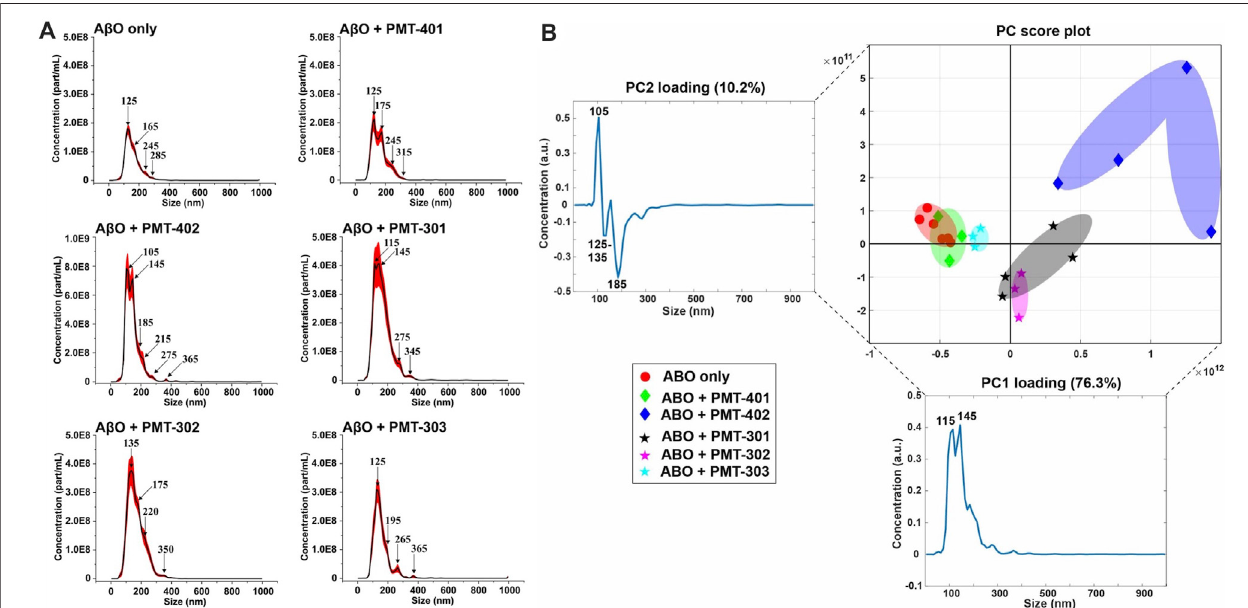
FIGURE8| NTAmeasurementsofA β OtreatedwitheachstilbenePALcandidate. (A) NanoparticleTrackingAnalysis(NTA)scatteringpro fi lesofA β Opreparations withand without PAL treatment. The black curves represent the average particle size vs. concentration distribution recorded and analyzed from 9 – 18× 30 s videos and theredcurvesdisplaythecorresponding±1standarddeviations. (B) Aprincipalcomponentanalysis(PCA)ontheNTAsizedistributiondatafordifferentcombinationsof A β O and stilbene PALs. The 2-dimensional PC score plot displays the separation of the tested groups: A β O alone (red circles) from a total of 1.23 × 10 5 particles detectedand analyzedand onaverage6.86×10 3 particles pervideodetected andanalyzed);A β O+PMT-401(green diamonds)fromatotalof3.56×10 4 particlesand on average 3.95 × 10 3 particles; A β O + PMT-402(blue diamonds) from a total of 6.26 × 10 4 particlesand on average 5.22 × 10 3 particles; A β O + PMT-301 (black stars) from a total of 1.35 × 10 5 particles and on average 7.51 × 10 3 particles; A β O + PMT-302 (magenta stars) from a total of 7.19 × 10 4 particles and on average 7.98 × 10 3 particles;A β O+PMT303(cyanstars)fromatotalof4.40×10 4 particlesandonaverage4.89×10 3 particles. ThePC1loadingexplains76.3%ofthetotalvariationinthe